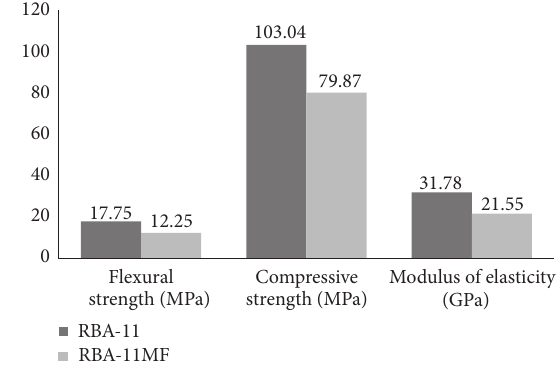
Figure 11: Comparison of the obtained mechanical properties from RBA-11 and